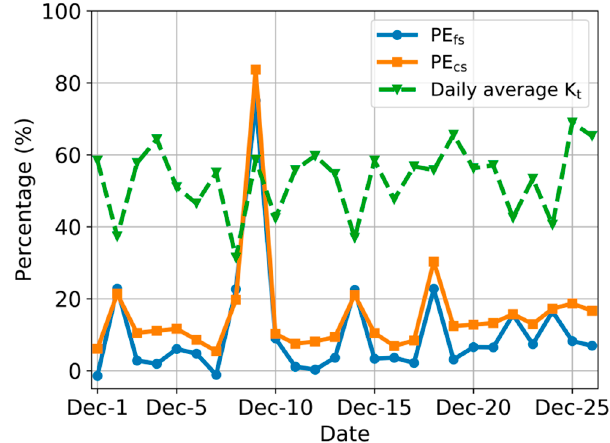
Figure 8. Daily average K t and PE fs , PE cs during experimental period.